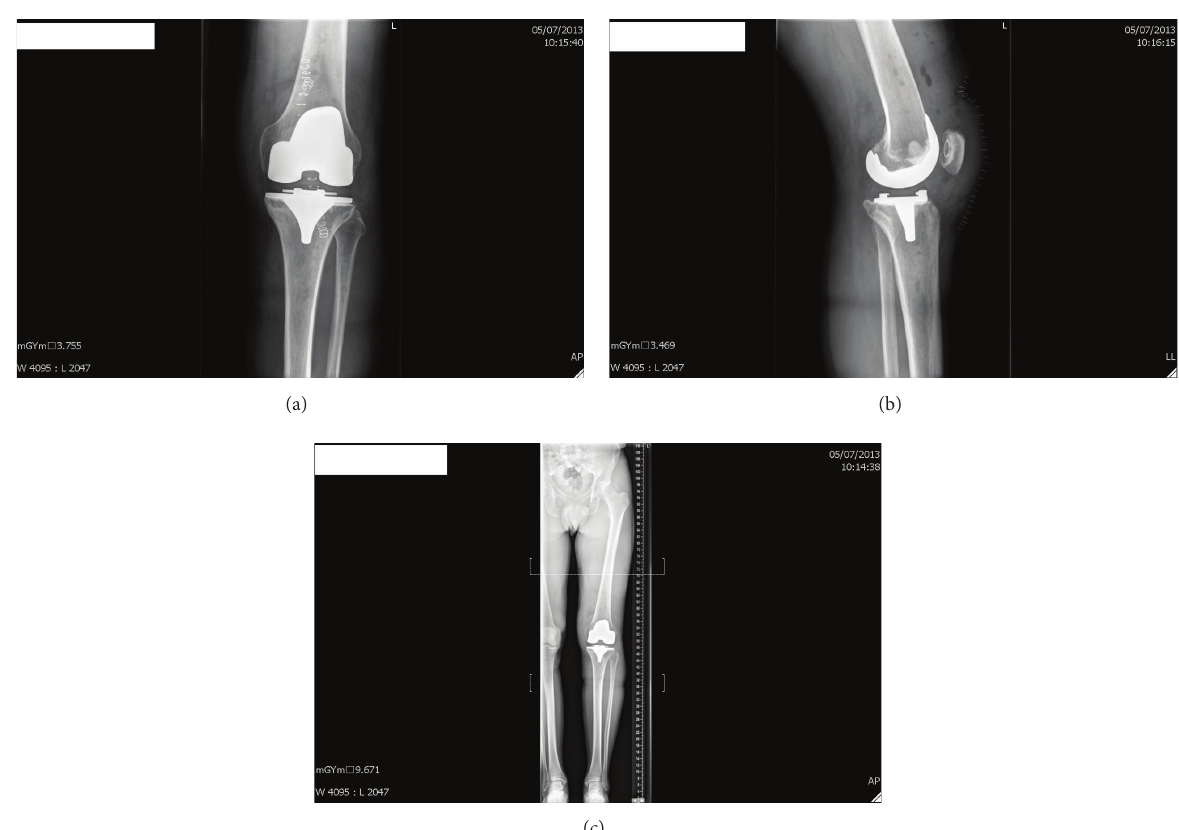
Figure 5: Anteroposterior (a), profile (b), and full leg view (c) X-rays of the knee after revision